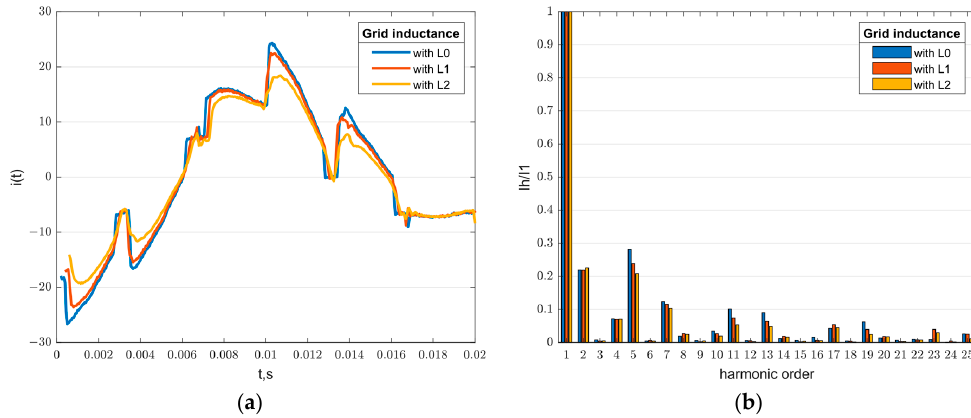
Figure 7. Waveforms ( a ) and harmonic spectrum ( b ) of aggregated load currents.